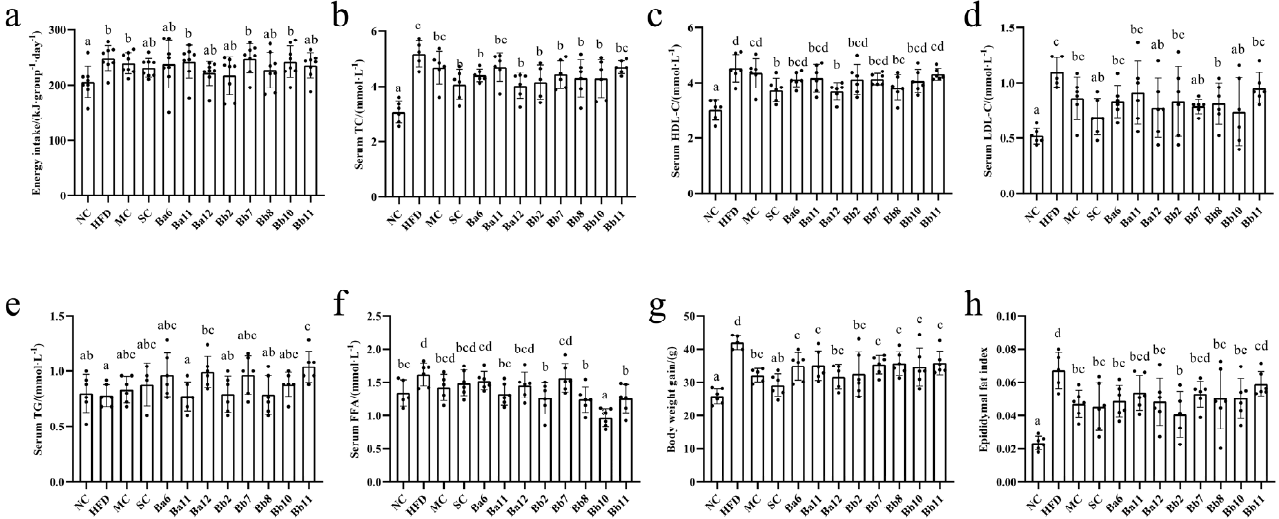
Figure 2. Effects of Bifidobacterium on energy intake and lipid metabolism in NAFLD mice. ( a ) energy intake; ( b ) TC in serum; ( c ) HDL-C in serum; ( d ) LDL-C in liver; ( e ) TG in serum; ( f ) FFA in serum; ( g ) body weight gain; ( h ) epididymal fat index. Mean values with different letters (a–d) over the bars are significantly different ( p < 0.05) according to Duncan’s multiple range